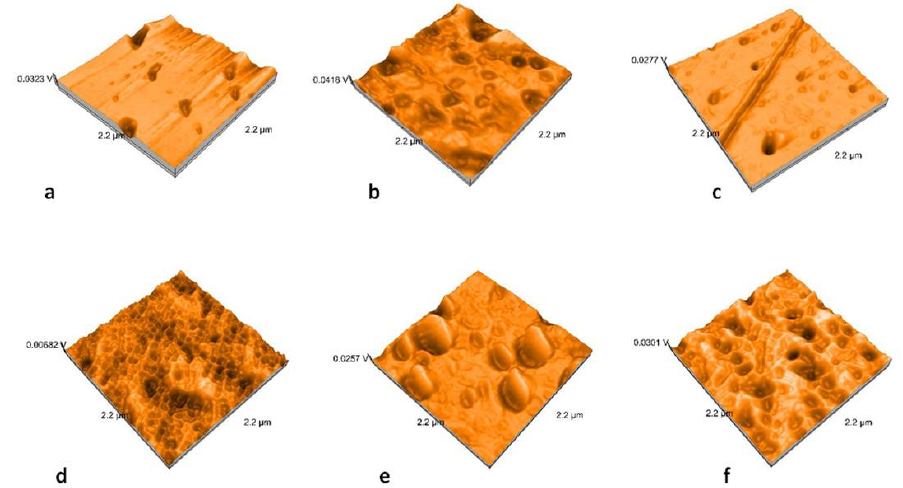
Figure 13. AFM images of the glazed samples after thermocycling: ( a ) LDS-P-G-HT, ( b ) LDS-P-G-MT, ( c ) LDS-M-G-MT, ( d ) ZLS-P-G-HT, ( e ) ZLS-P-G-MT, and ( f ) ZLS-M-G-MT. There is a moderate negative Spearman correlation between microroughness Ra and nano roughness Sa (−0.581). 3. Discussion In dentistry, optical properties play an essential role in treatment success and patient satisfaction. Besides color, translucency, and opalescence of restorative materials are critical factors in aesthetic rehabilitation. The very fine microstructure in ZLS could be related to a strong interface between the zirconia enriched matrix and very fine crystals of lithium silicate. The combination of a brittle ceramics matrix enriched with high strength ceramic particles or dispersed oxides can result